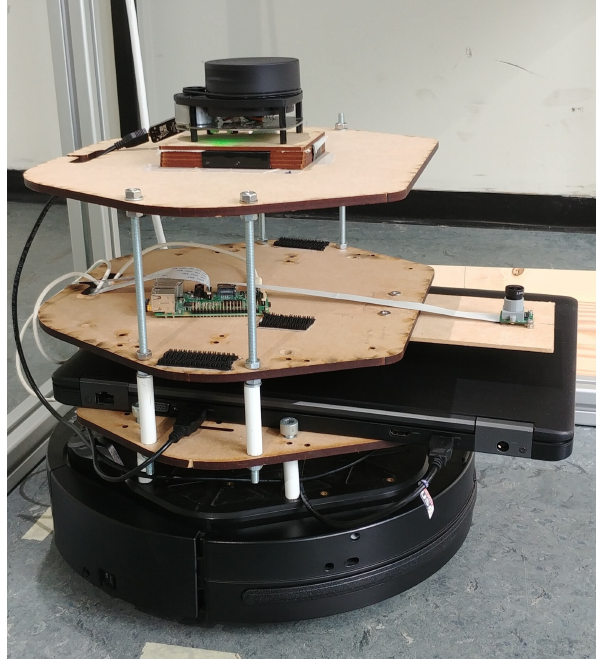
Figure 3. Mobile robot with custom sensor platform used in this paper, which was also used in our previous work